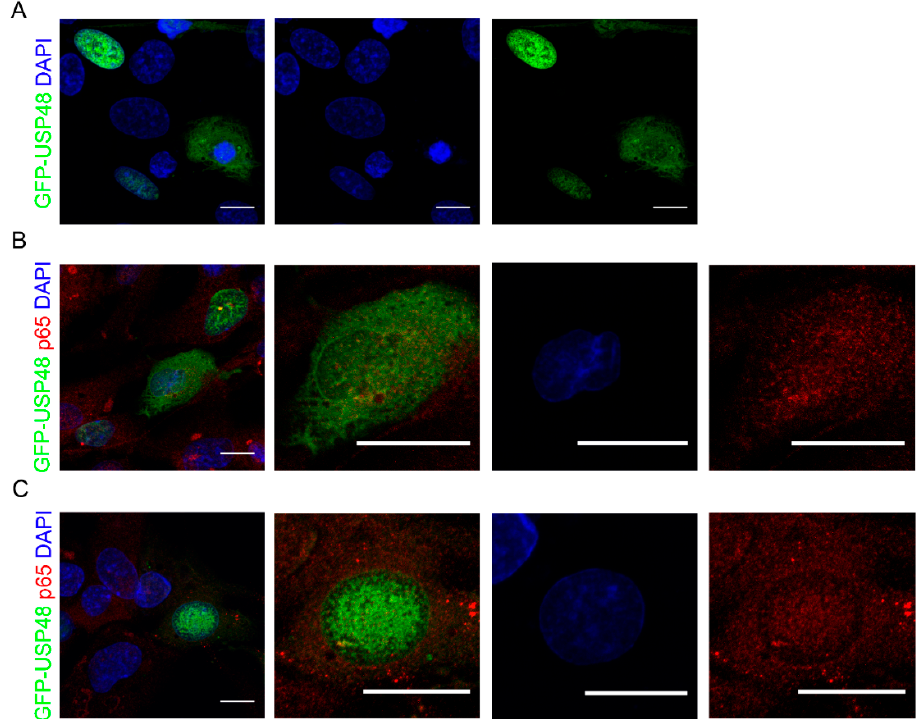
Figure 1. USP48 colocalizes with p65 and its overexpression promotes p65 nuclear localization. Immunofluorescence images from hTERT-RPE1 transfected with GFP-USP48 (green). ( A ) GFP-USP48 is localized mainly in the nuclei, while cytosolic staining is occasionally seen in individual cells. ( B , C ) Endogenous p65 (red) partially colocalizes with GFP-USP48 in both cytosolic and nuclear compartments. Regions of interest (ROIs) represent higher magnification from left panels. Nuclei were stained with DAPI (blue). Scale bars: 15 μ m and 20 μ m in higher magnification images.